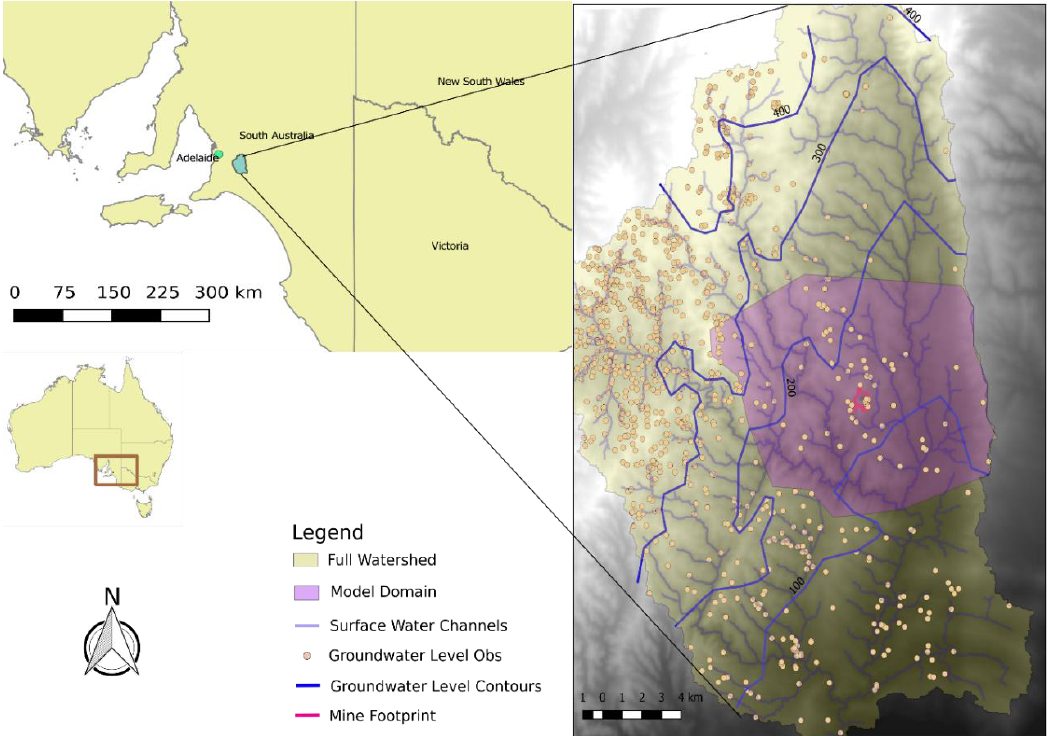
Figure 1. Location of the Kanmantoo mine site and data used to develop a conceptual model of groundwater flow.